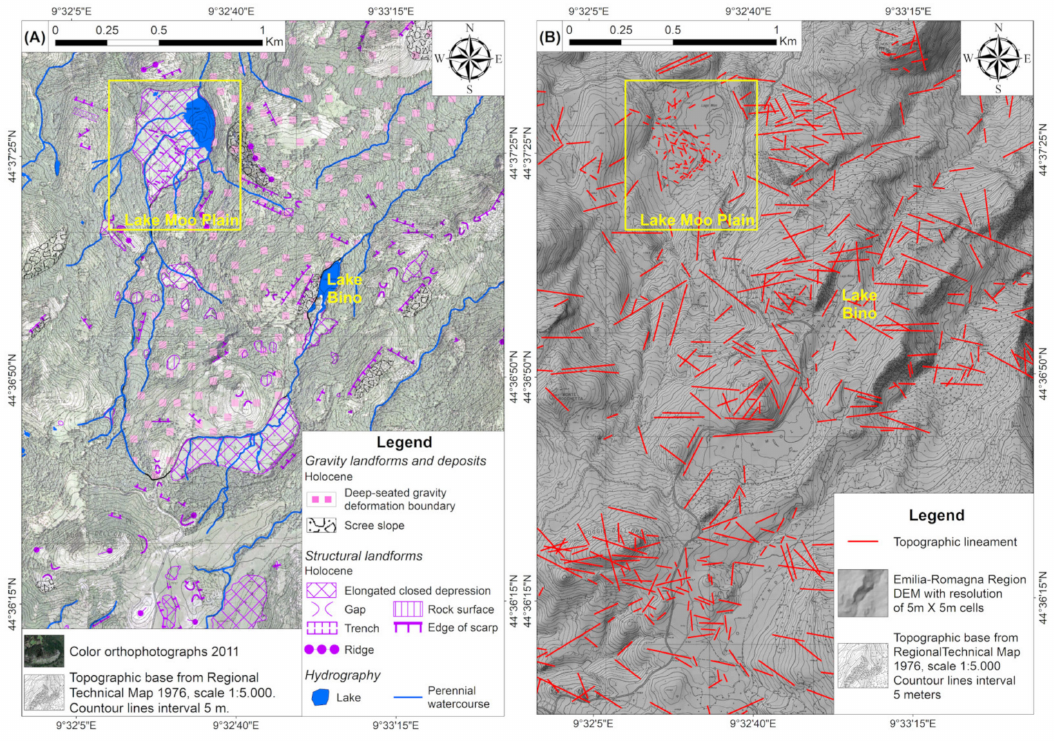
Figure 9. Main geomorphological features surrounding the study area. ( A ) Map of geomorphic structures. ( B ) Map of topographic